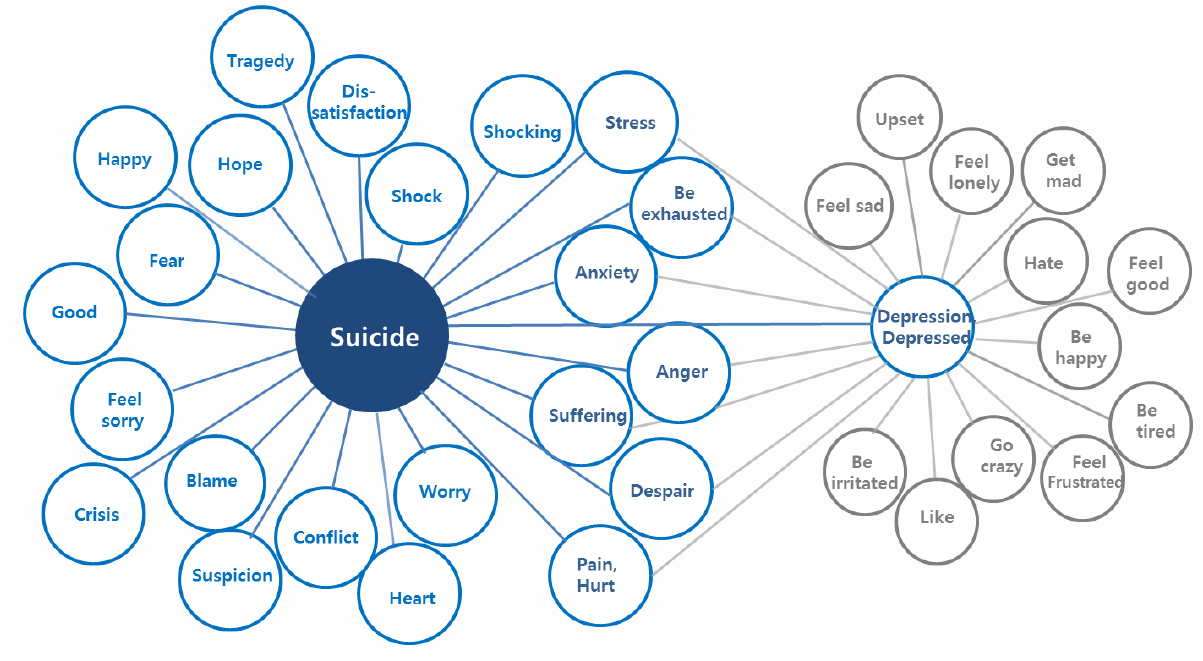
Figure 3. Emotional words most frequently associated with suicide. This diagram shows the words most associated with jasal (suicide) and/or wooul (depression) during three years. Individual words inside the blue circle are the words associated with suicide, and the word “Depression” is one of these words. The link is defined by association. These data were collected from daily Twitter posts between January 2011 and December